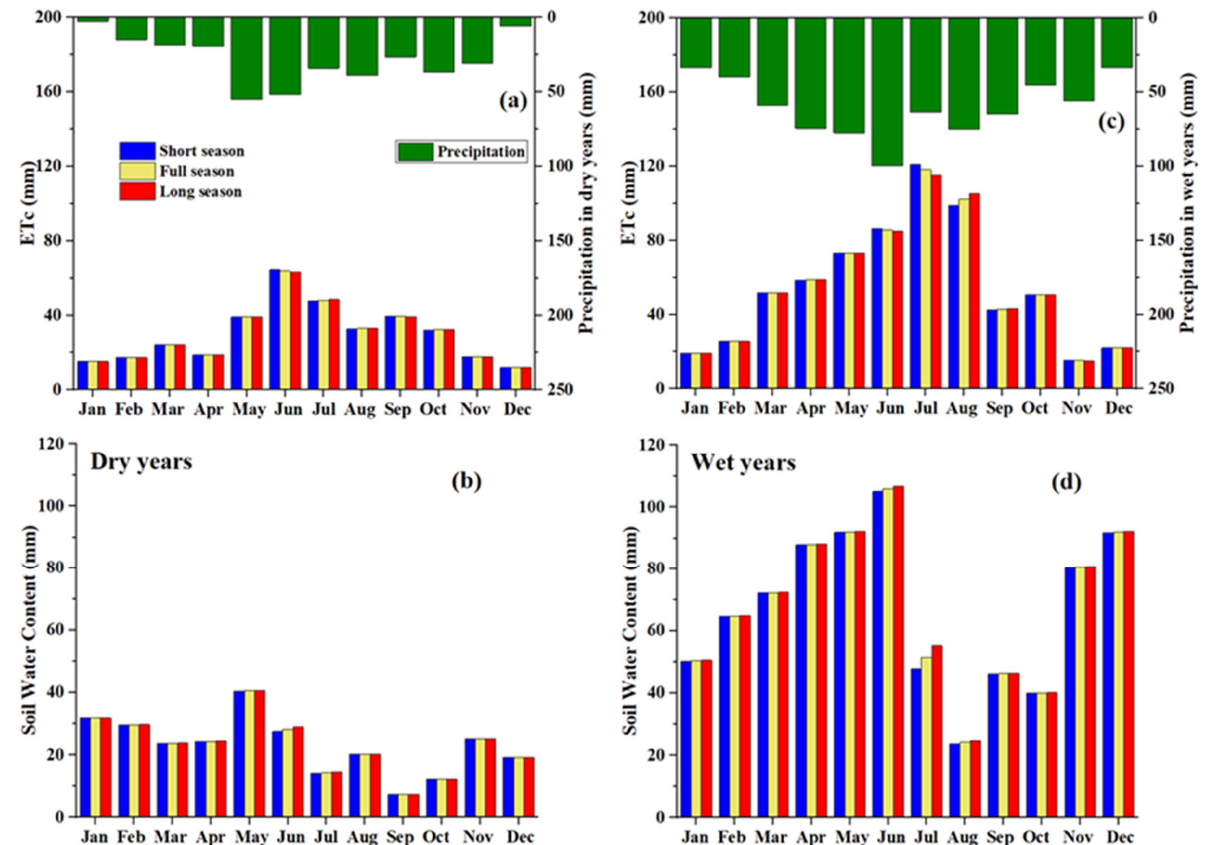
Figure 7. Comparison of average monthly crop evapotranspiration (ET c ) ( a , c ) and soil water content ( b , d ) during dry and wet years using different maturity cultivars in the dryland cotton HRUs in the Double Mountain Fork Brazos basin.